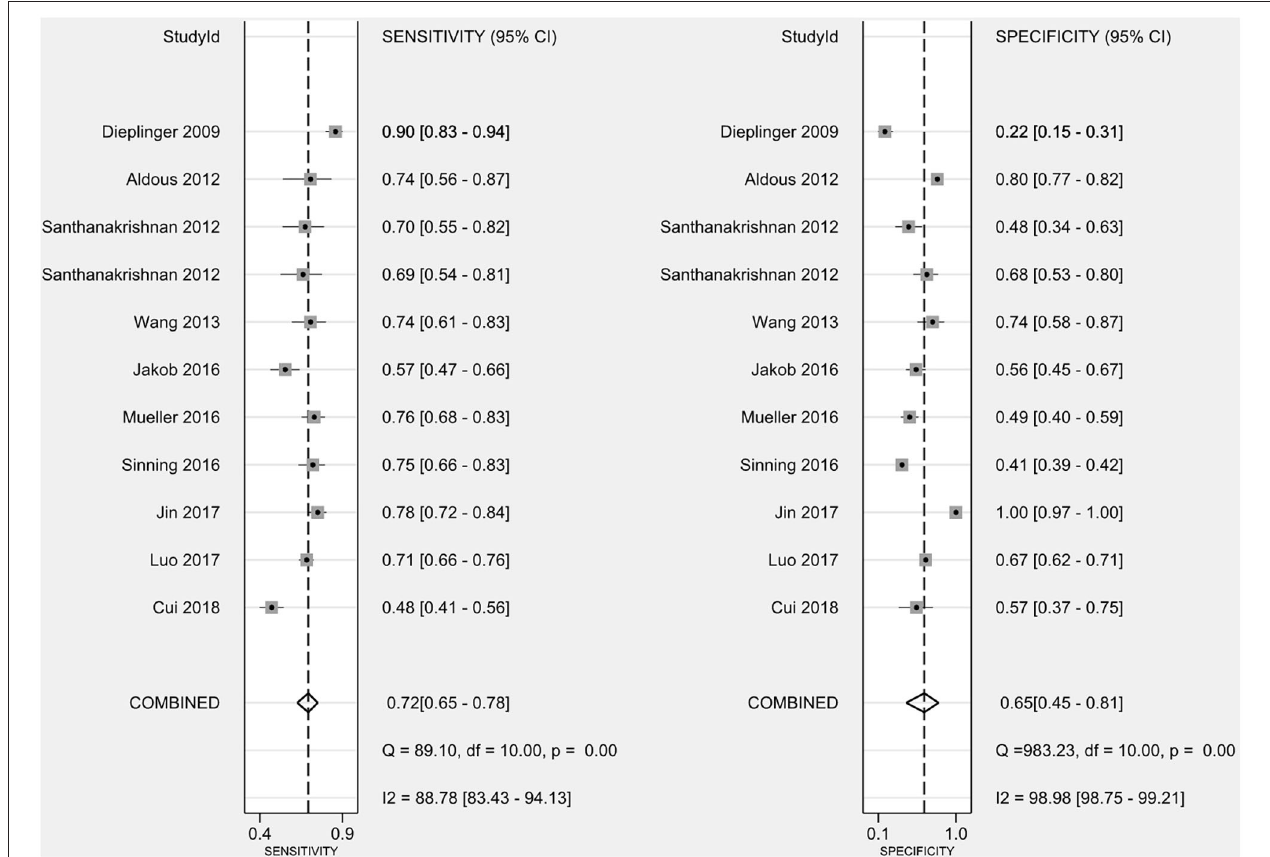
FIGURE 3 | The combined sensitivity and specificity of sST2 for the diagnosis of HF. sST2, soluble suppression of tumorigenicity; HF, heart